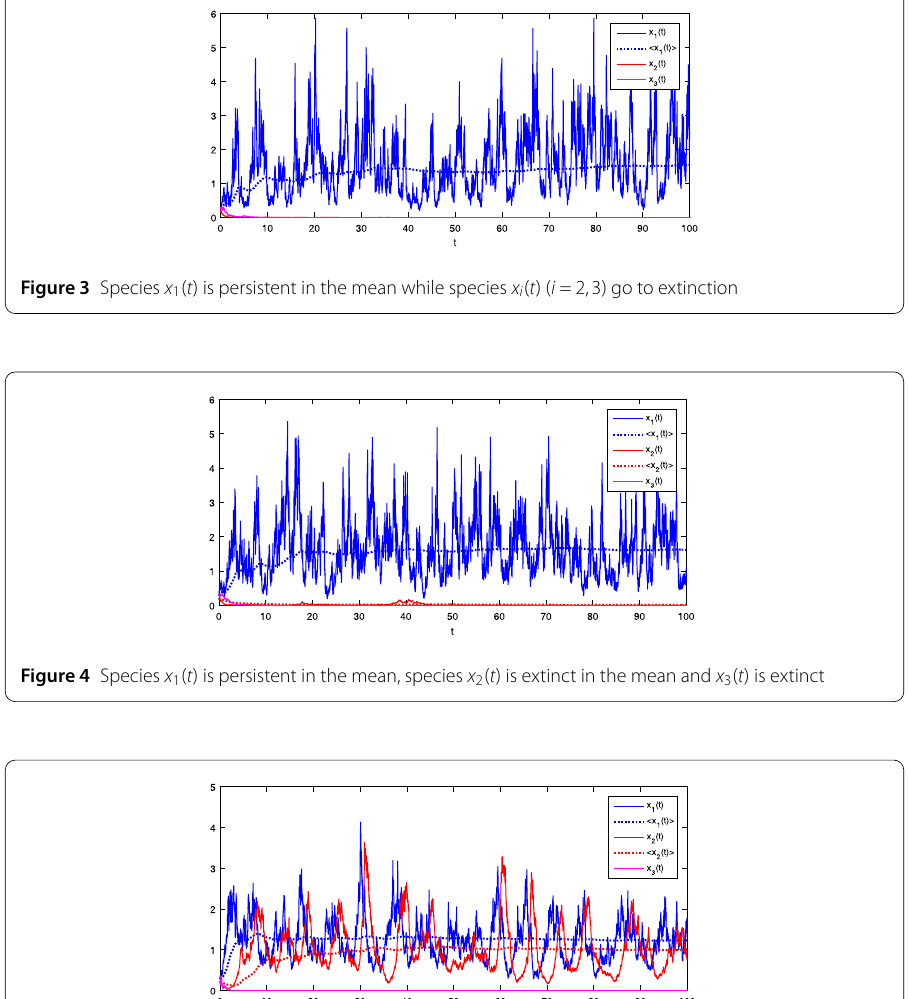
that species x 1 ( t ) is persistent in the mean, species x 2 ( t ) is extinct in the mean and x 3 ( t ) is